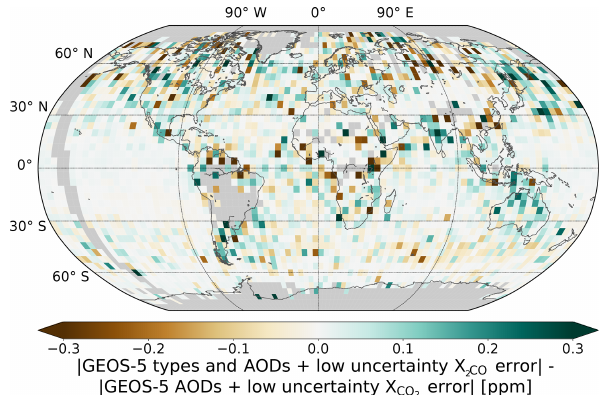
Figure 11. The 4 ◦ × 4 ◦ binned absolute value of GEOS-5 types and AODs with low-uncertainty X CO error against the model 2 validation minus the absolute value of GEOS-5 AODs with low- uncertainty X CO error against the model validation. Green grid 2 cells represent an improvement relative to the model validation while brown grid cells represent a worse comparison to the model validation. Grey bins represent no